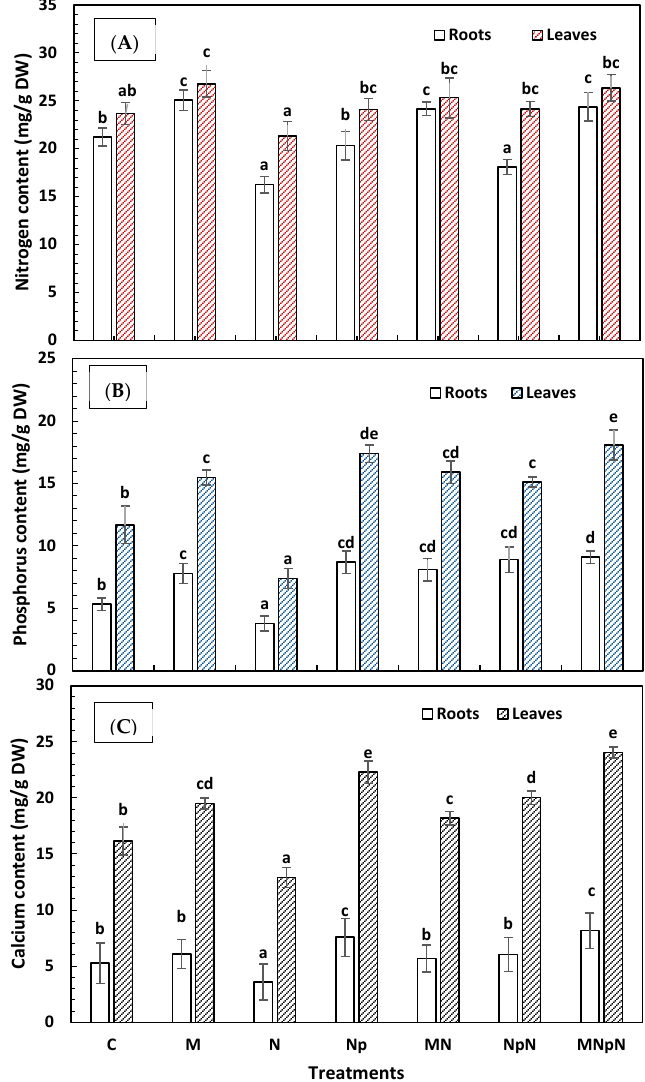
Figure 4. Mineral contents (mg/g DW) ( A ) nitrogen, ( B ) phosphorus, and ( C ) calcium in roots and leaves of healthy and M . incognita -infected tomato plants inoculated with mycorrhizal fungi and treated with n-HAP. Healthy plants without any inoculation ( C ); plants inoculated with AMF (M); plants infected with M . incognita (N); plants treated with HAP nanoparticles (Np); plants infected with M . incognita and inoculated with AMF (MN); plants infected with M . incognita and treated with n-HAP (NpN); plants infected with M . incognita and treated with AMF and n-HAP (MNpN). Vertical bars indicate ± SE ( n = 4); columns in the same pattern and followed by different letters are significantly different at p < 0.05.